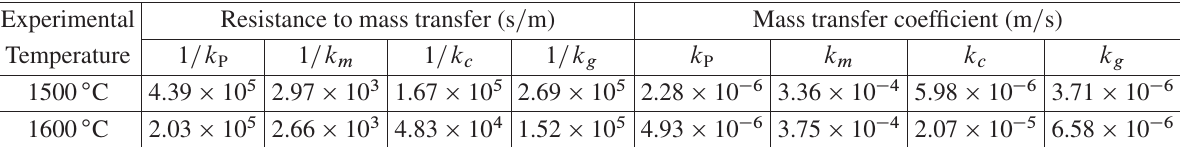
Table 2. The determined kinetic parameters for the mass transfer of phosphorus from the silicon melt to the gas